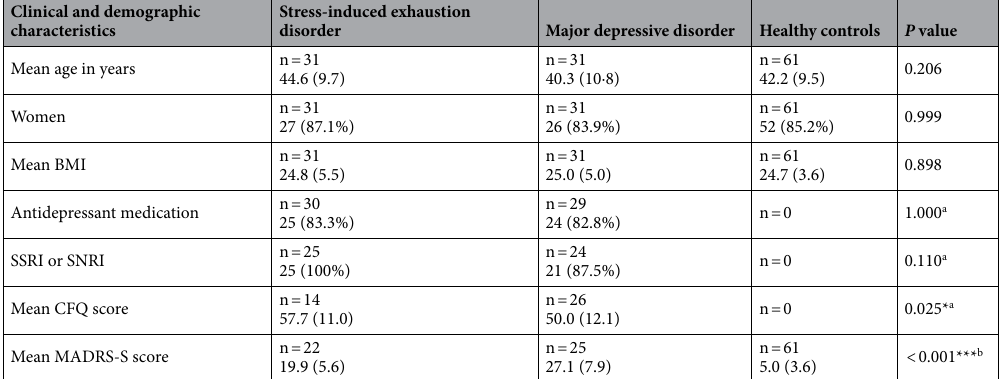
Table 2. Clinical and demographic characteristics of patients with stress-induced exhaustion disorder (n = 31), patients with major depressive disorder (n = 31), and healthy controls (n = 61). Data are mean (SD) or n (%). BMI body mass index, CFQ cognitive failures questionnaire, MADRS-S self-reported version of the Montgomery–Åsberg Depression Rating Scale, SNRI serotonin and norepinephrine reuptake inhibitor, SSRI selective serotonin reuptake inhibitor. a The P value represents the difference between patients with stress- induced exhaustion disorder and patients with major depressive disorder. b The P value represents the results of the comparison of all three groups. Further analyses showed a statistically significant difference between patients with stress-induced exhaustion disorder and healthy controls and between patients with major depressive disorder and healthy controls.